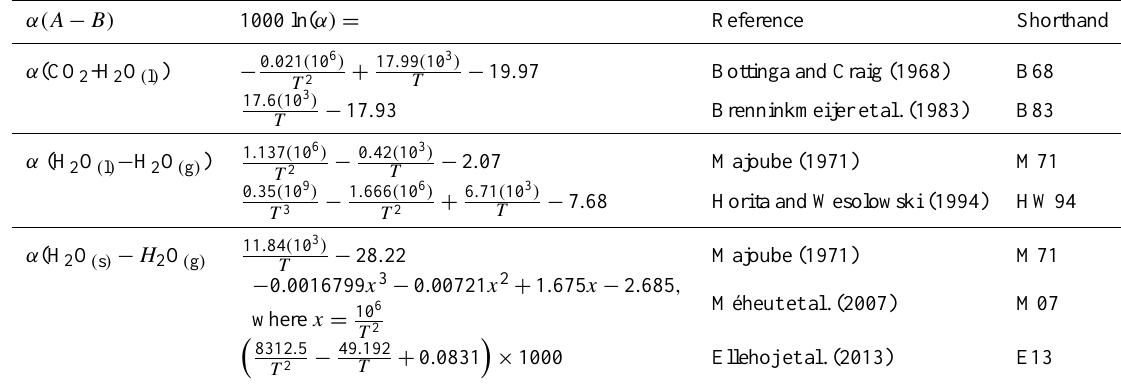
Table 4. δ 18 O fractionation